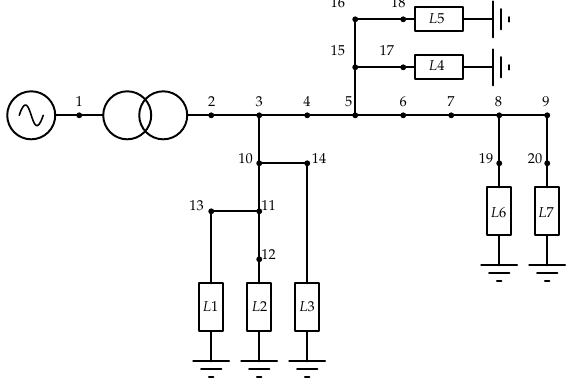
Figure 2. Schematic of the circuit used for the validation of the EKF-based method [17]. The segments between each couple of nodes correspond to r-l lines, whose parameters are specified in the Appendix A.